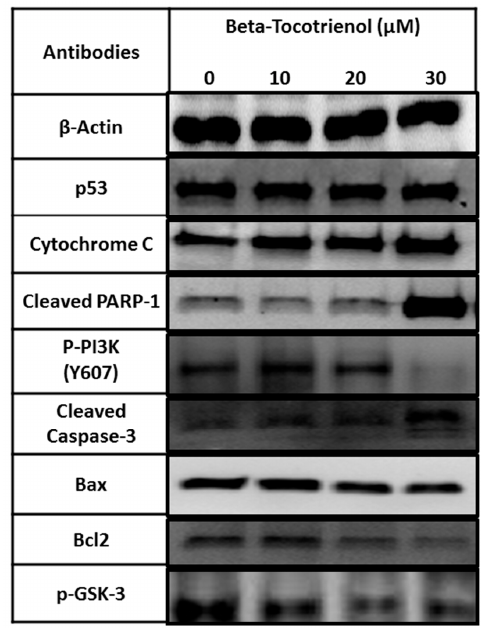
Figure 7. Beta-Tocotrienol remarkably up-regulates the pro-apoptotic protein expression of cytochrome c, increased caspase-3, and PARP-1 cleavages and downregulates Bcl-2 and two proliferation mediating proteins: p-PI3K and p-GSK3 in 24 h treated MDA-MB-231 cell lines. Western blot analysis of Bax, Bcl-2, p53, cytochrome C, cleaved PARP-1, cleaved caspase-3, p-PI3K, p-GSK3 and β -actin from untreated control and 10, 20 and 30 μ M treated MDA-MB-231 breast cancer cells. Biomolecules 2020 , 10 , x FOR PEER REVIEW